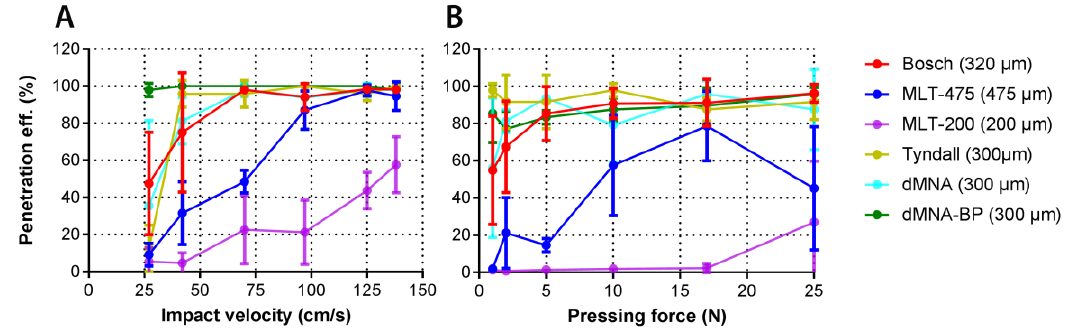
Figure 9. Penetration efficiency (in percentage) of MNs on ex vivo human skin as a function of the microneedle impact velocity ( A ) and pressing force ( B ). Data are shown as mean ± SD, n = 3. Table 3. MNA application parameters used to investigate skin piercing of the six different MNAs via impact insertion.